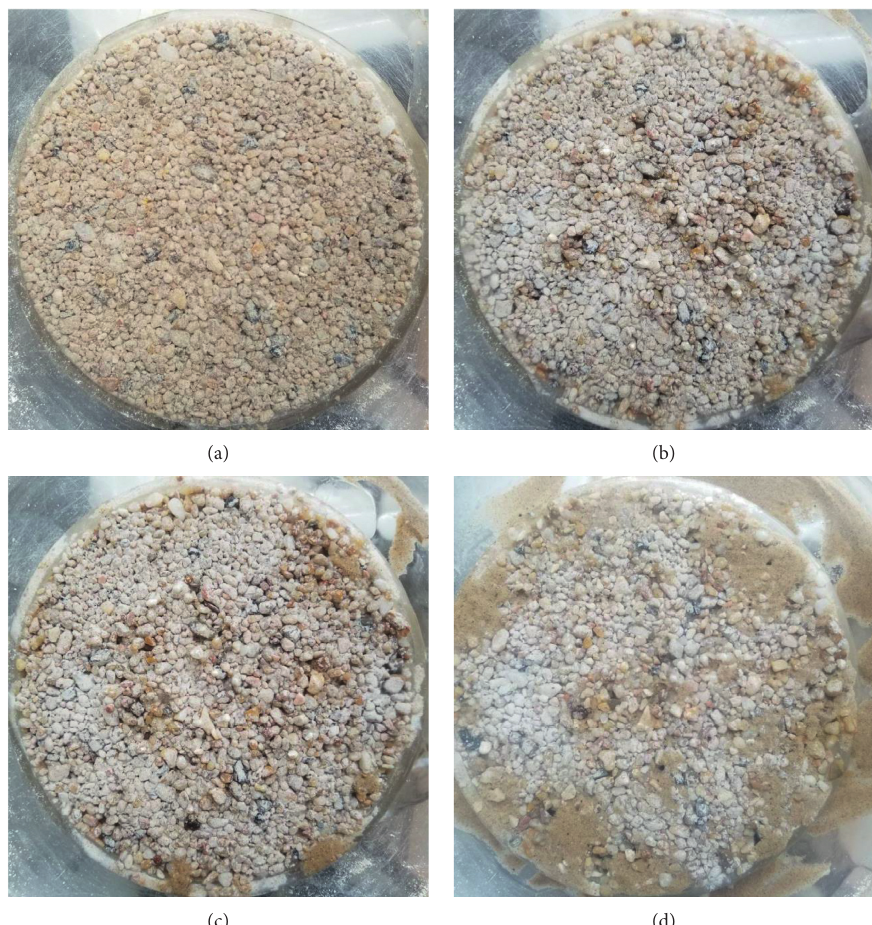
Figure 5: Observed particle migrations from top (specimen CS-3). (a) Stable seepage i � 0.16. (b) Seepage development i � 0.46. (c) Seepage failure i � 0.71. (d) Completely destroyed i �